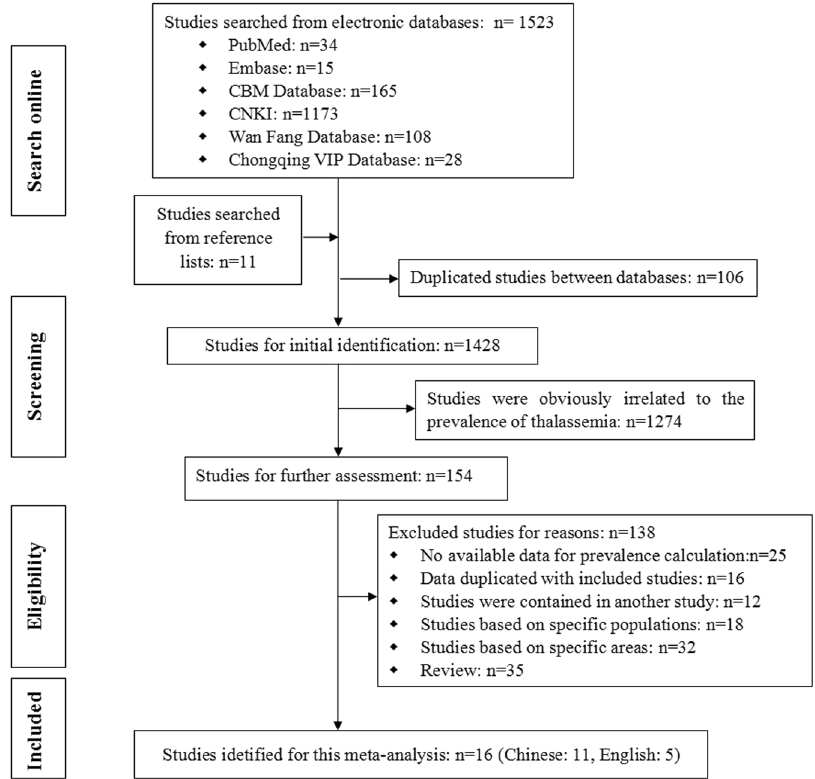
Figure 1. Flow chart of the selection process for the included